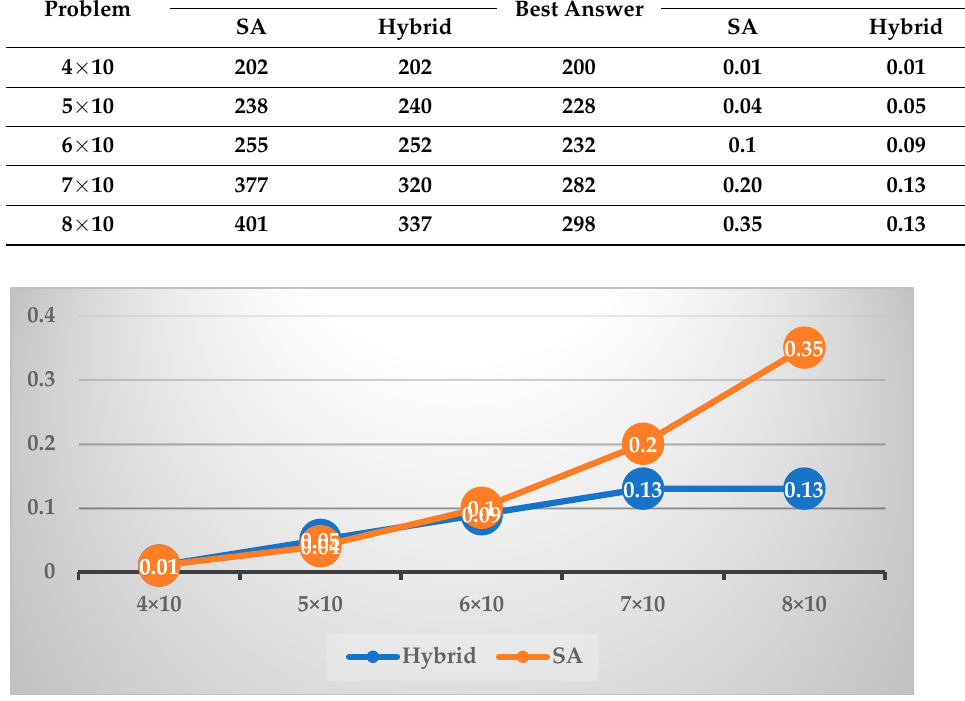
Figure 19. Fitness diagram of SA and hybrid SA in the fourth quarter (10 ORs). Table 10. Results of executing the SA and hybrid SA algorithms in the fourth quarter (15 ORs) .